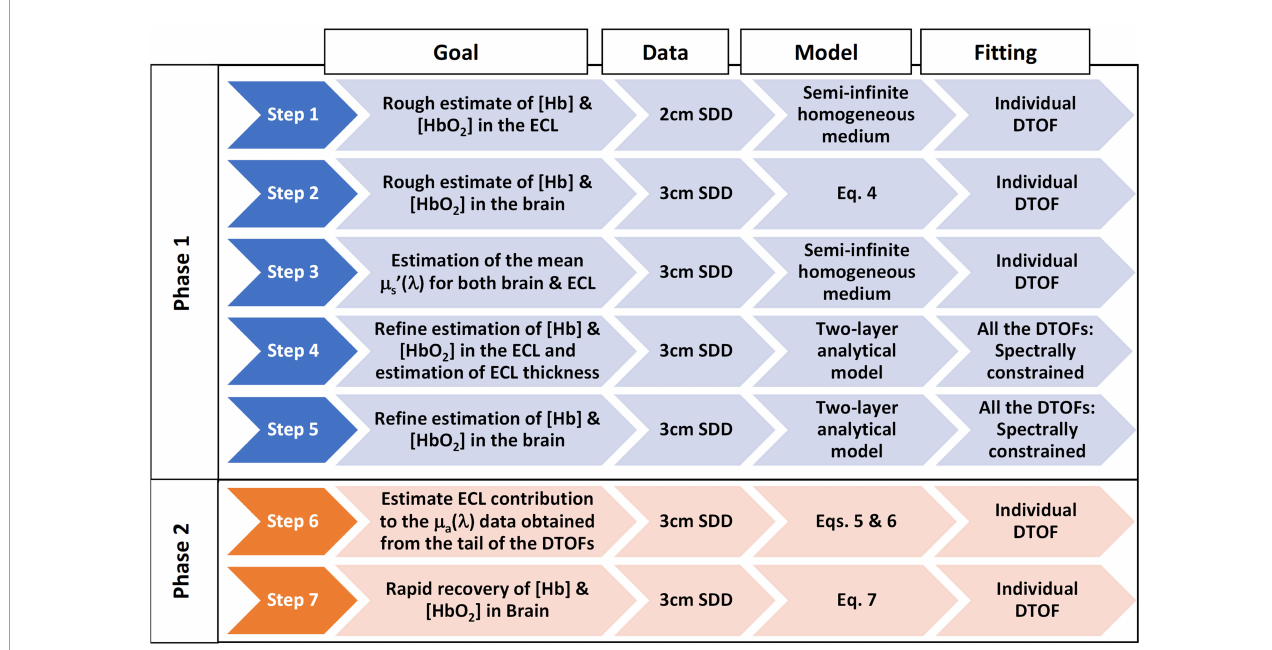
FIGURE1 Flowchart of the two-phase hyperspectral trNIRS data analysis algorithm. The following provides additional information on each step of the algorithm. Step 1: 1st fitting: Fitted for Amplitude, µ a ( λ ), and µ s ’( λ ); 2nd fitting: Amplitude was fixed to the mean value obtained in the 1st fitting and fitted for µ a ( λ ) and µ s ’( λ ); 3rd fitting: Amplitude and µ s ’( λ ) were fixed to the values obtained in the 1st and 2nd fitting, and fitted for µ a ( λ ) only; Computed [Hb] and [HbO 2 ] from µ a ( λ ). Step 2: The tail of the logarithm of the DTOFs was fit to obtain µ a ( λ ); Computed [Hb] and [HbO 2 ] from µ a ( λ ). Step 3: 1st fitting: Fitted for Amplitude, µ a ( λ ), and µ s ’( λ ); 2nd fitting: Amplitude was fixed and fitted for µ a ( λ ), and µ s ’( λ ); the latter were used as the mean reduced scattering coefficient for both brain and ECL. Step 4: [Hb] and [HbO 2 ] in the brain were fixed to the values obtained in Step 2; µ s ’( λ ) fixed to values obtained in Step 3; Fitting parameters: ECL thickness, and [Hb] and [HbO 2 ] in the ECL; The initial guess of [Hb] and [HbO 2 ] were the values obtained in Step 1 and were allowed to vary ± 50%; ECL thickness was set to the average value obtained from the segmented MRI and allowed to vary ± 10%. Step 5: [Hb] and [HbO 2 ] in the ECL were fixed to the values obtained in Step 4; µ s ’( λ ) fixed to values obtained in Step 3; Fitting parameters: [Hb] and [HbO 2 ] in the brain; The initial guess of [Hb] and [HbO 2 ] in the brain was 30 µ M and allowed to vary between 0 and 80 µ M. Step 6: The absorption coefficients in the ECL, µ a the brain, µ a ( λ ), obtained from Steps 4 and 5 were used to estimate the ECL contribution (f ECL ) to the absorption coefficients from the late-photon Brain analysis, µ a ( λ ). Step 7: For any subsequent trNIRS spectrum (i.e., DTOFs dataset), the absorption coefficient in the brain, µ a Lp estimated from the baseline absorption coefficients in the brain and ECL, and the ECL contribution to the absorption coefficients obtained from late photon analysis of the DTOFs (f ECL